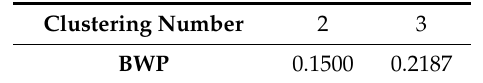
Table 6. BWP index of Z 32 with different number of clusters.